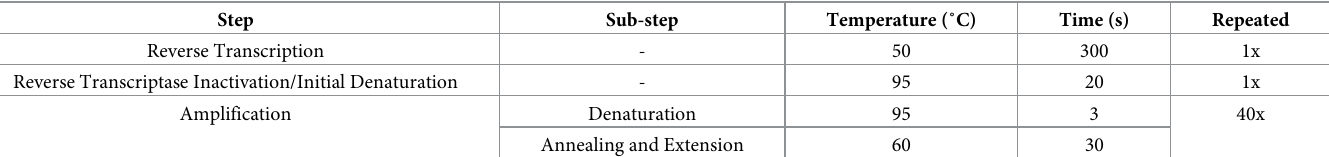
Table 2. RT-PCR cycling